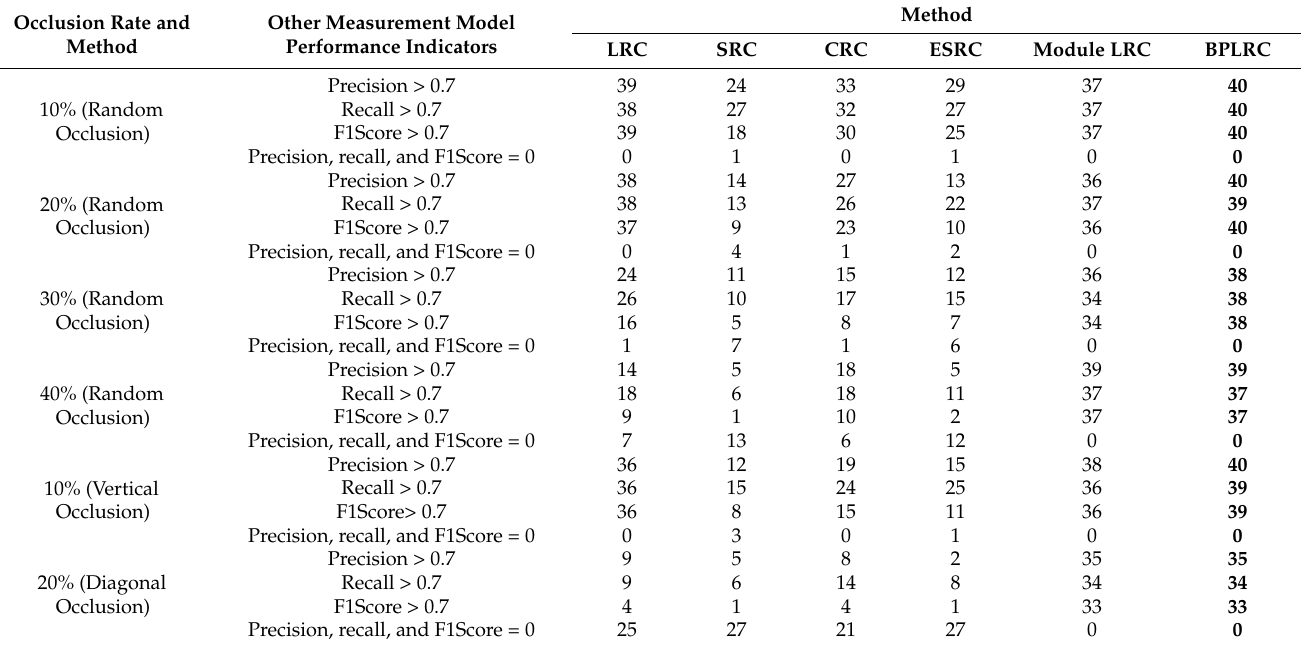
Table 12. The number of categories that identified performance indicators to an extent greater than 0.7 or single categories that were wrongly identified from ORL datasets for different